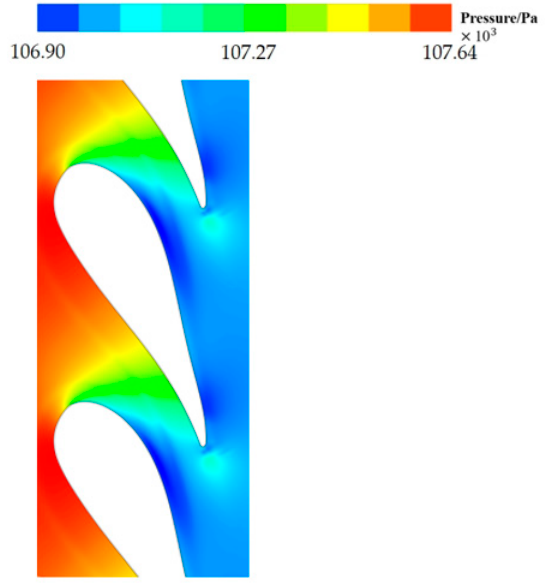
Figure 3. Static pressure distribution on the endwall.